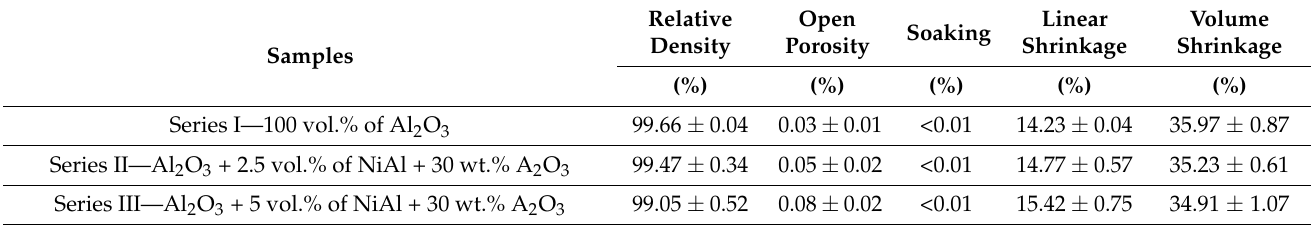
Table 2. Selected physical properties of the samples.